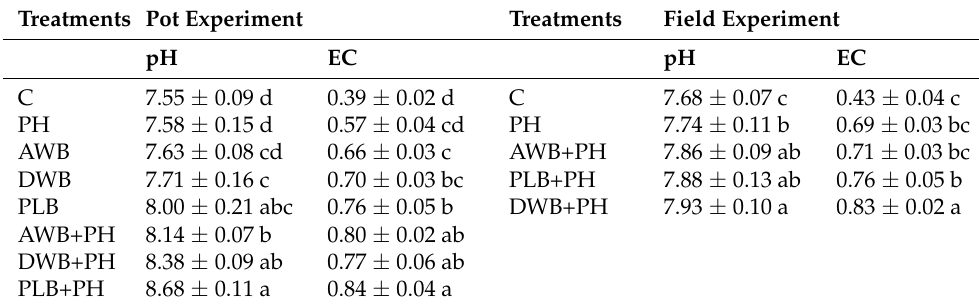
Table 3. pH and EC content of soil under the effect of each treatment. Treatments Pot Experiment Treatments